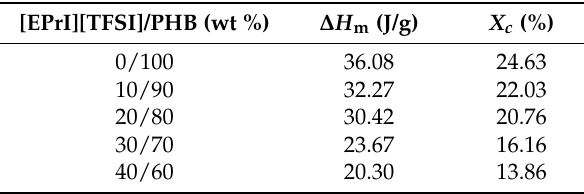
Table 1. Δ H m and X c values of the [EPrI][TFSI]/PHB blends. Table 1. ∆ H m and X c values of the [EPrI][TFSI]/PHB blends.